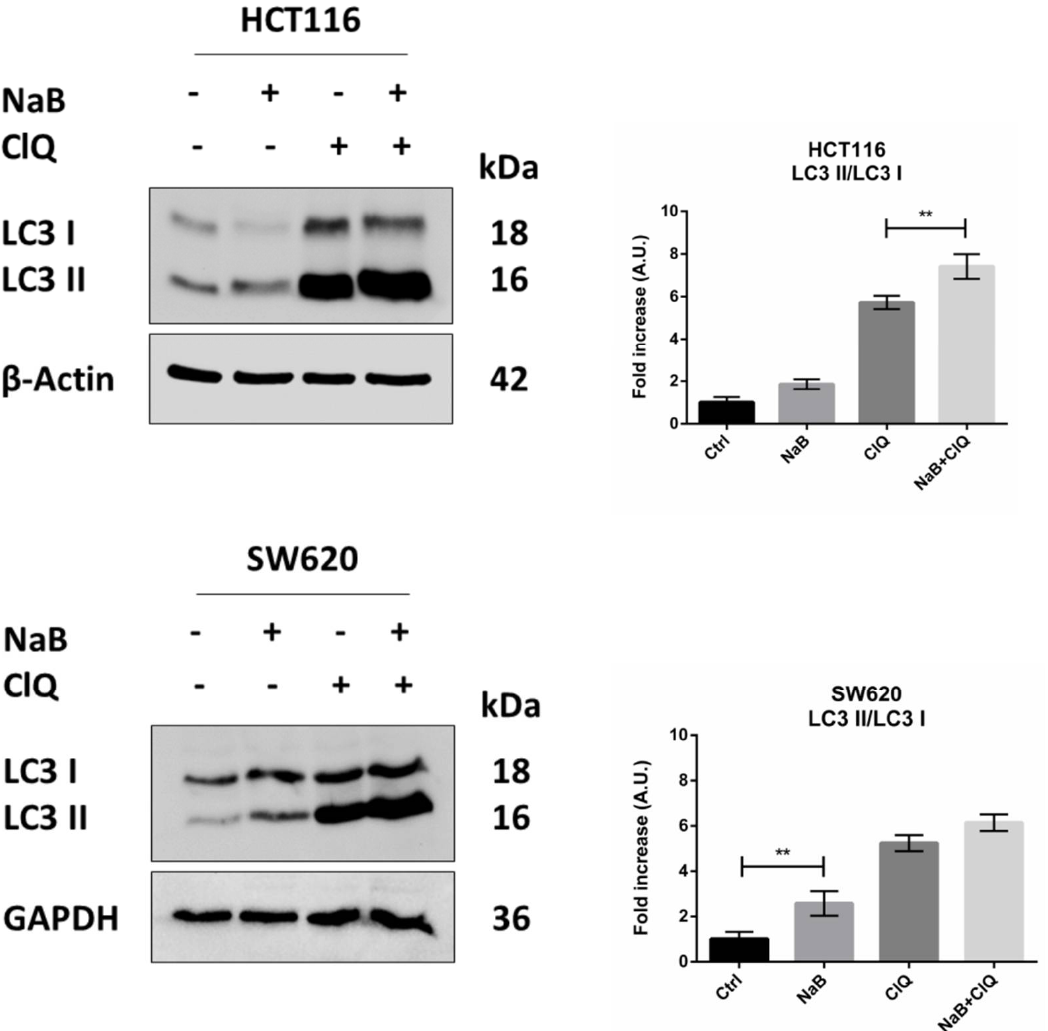
Figure 6. NaB stimulates the processing of LC3. HCT116 and SW620 cells adherent on petri dishes were incubated with 2 mM NaB for 48 h in the presence or in the absence of 30 μM chloroquine (added 24 h before cell collection). Medium was replaced and substances re-added every 24 h. At the end of the experimental time point, cell homogenates were analyzed by Western blotting for the expression of LC3. The filter was re-probed with β-Actin or GAPDH as a loading control. A representative Western blot out of three, with reproducible data, is shown, and densitometric data are shown in the panel. The graphs represent the average ± SD (significance was considered as follow: ** p < 0.01).